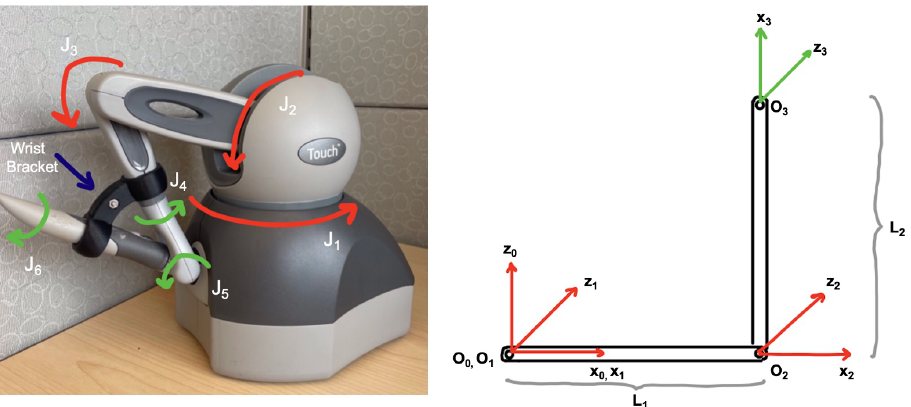
Figure 4. Omni bundle robot used for prototyping the SlicerROS2 module. Previously known as the SensAble Phantom Omni or Geomagic/3DS Touch. Joints labeled in red are actuated, while joints labeled in green are not. ( Left ) Labeled device. ( Right ) Device coordinate frames such that L1 and L2 are the link